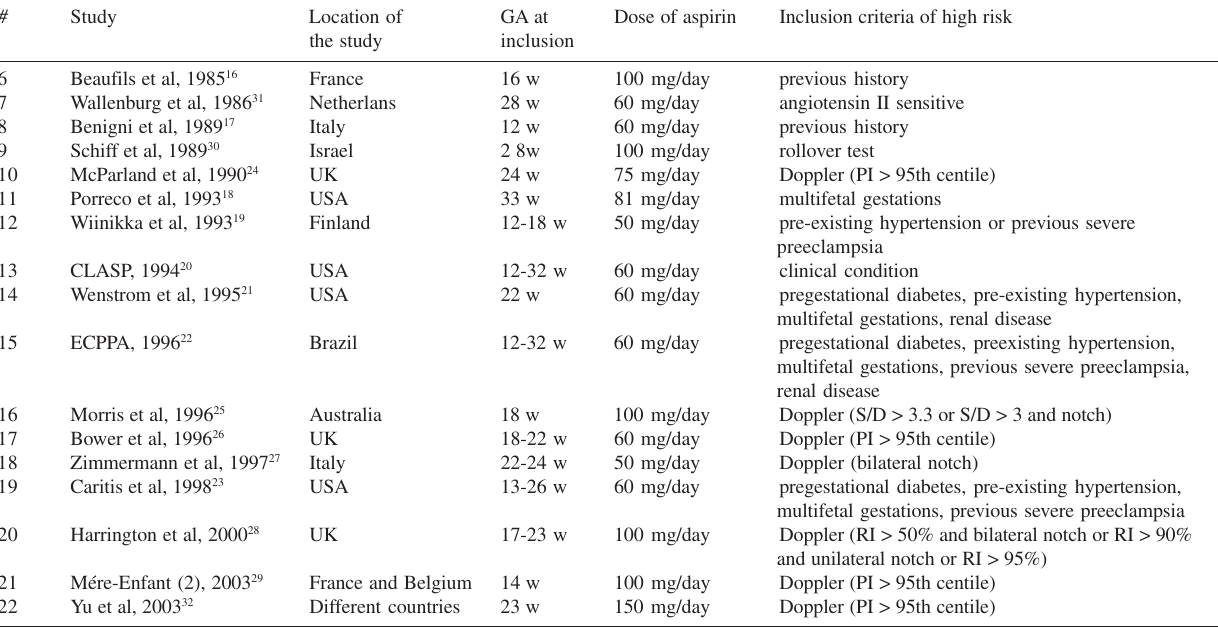
Table 2 - Characteristics of randomized trials including women at high risk for preeclampsia